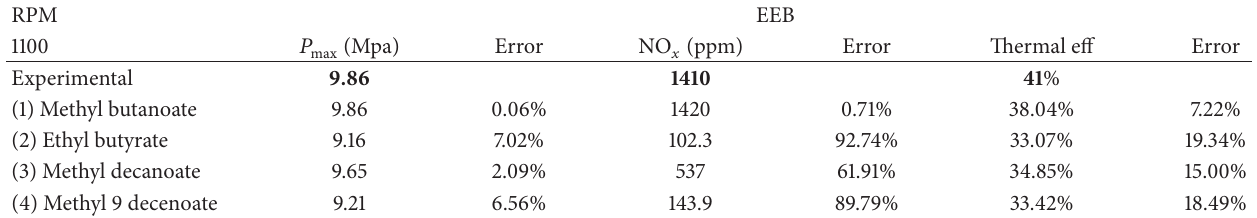
Table 7: Comparative experimental and simulated results for ethyl ester biodiesel and each surrogate at 1100rpm.